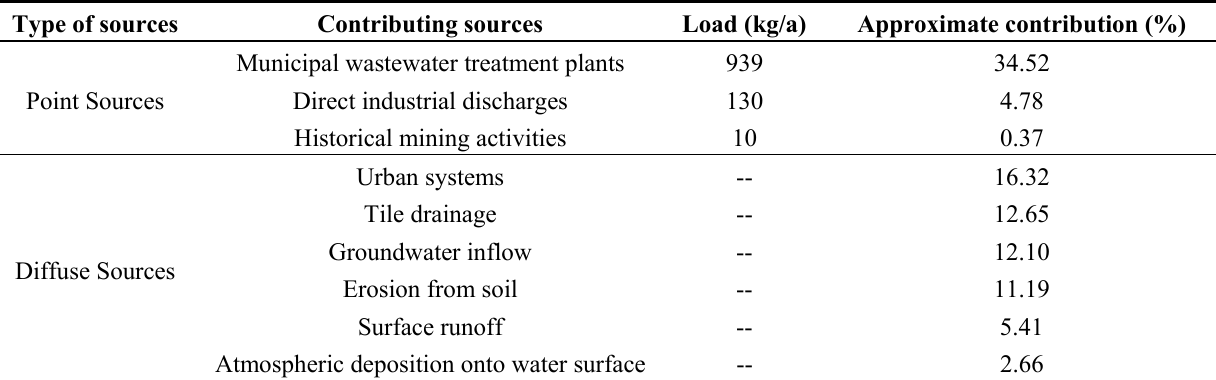
Table 1. Point and diffuse mercury emissions in Germany into the river basin districts and seas in the balance period 2003–2005